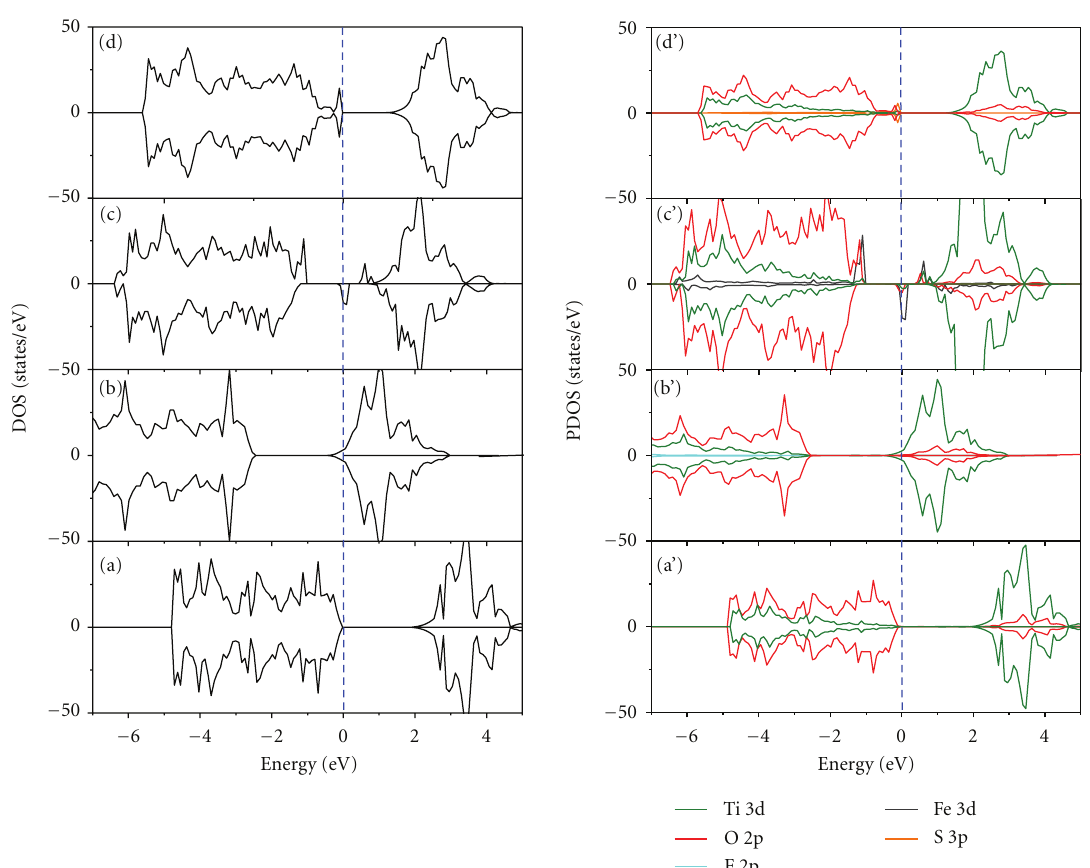
Figure 2: Total density of states (DOS) of (a) undoped anatase TiO 2 , (b) F-doped TiO 2 , (c) Fe-doped TiO 2 , and (d) S-doped TiO 2 and projected density of states (PDOS) of (a (cid:3) ) pure TiO 2 , (b (cid:3) ) F-doped TiO 2 , (c (cid:3) ) Fe-doped TiO 2 , and (d (cid:3) ) S doped TiO 2 . The dashed line represents the Fermi energy